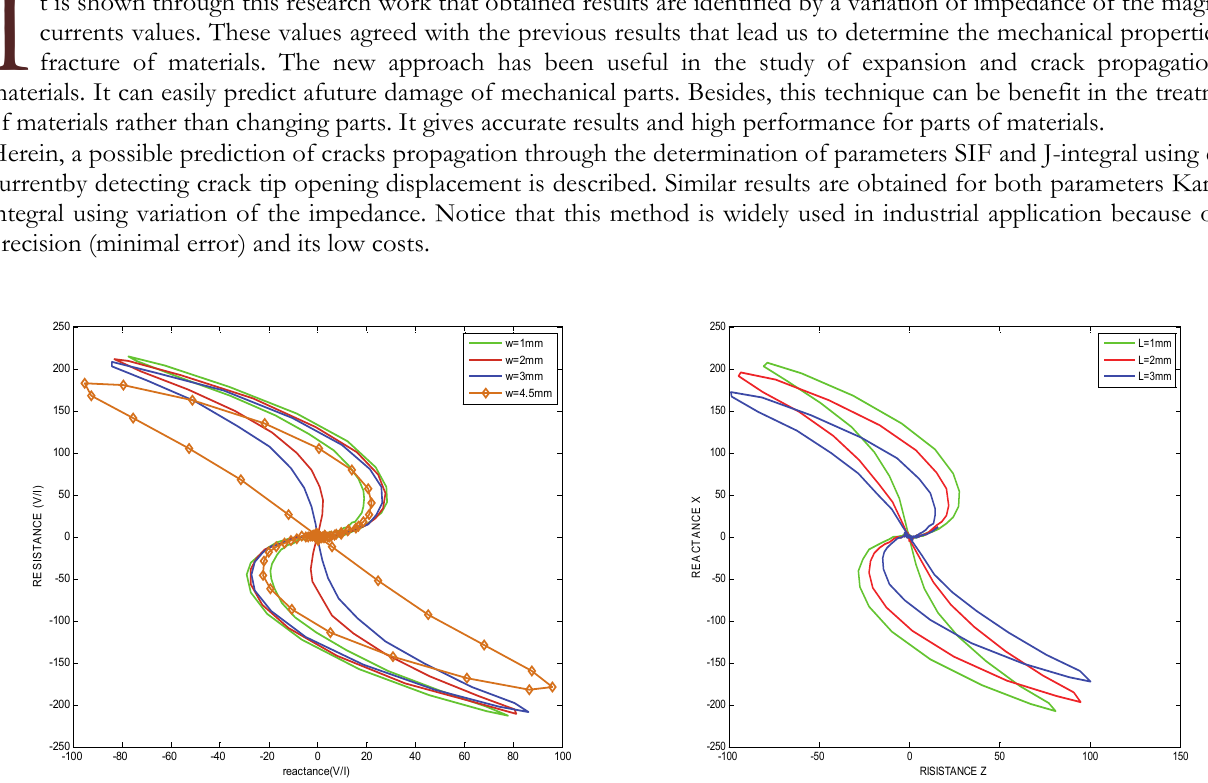
Figure 14: Evaluation of resistance and reactance sensor vs. crack